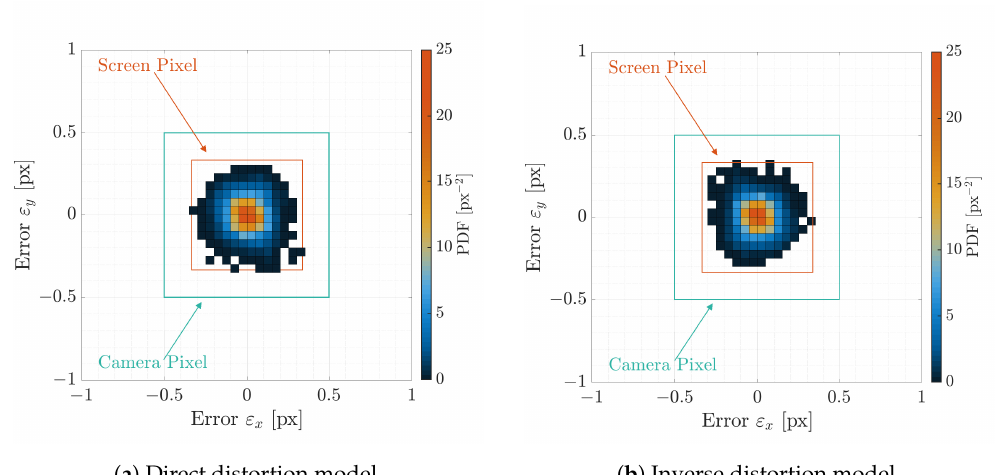
(cid:0) (cid:1) T ε x , ε y for the two distortion models during and the screen iFoV θ s IFoV IFoV